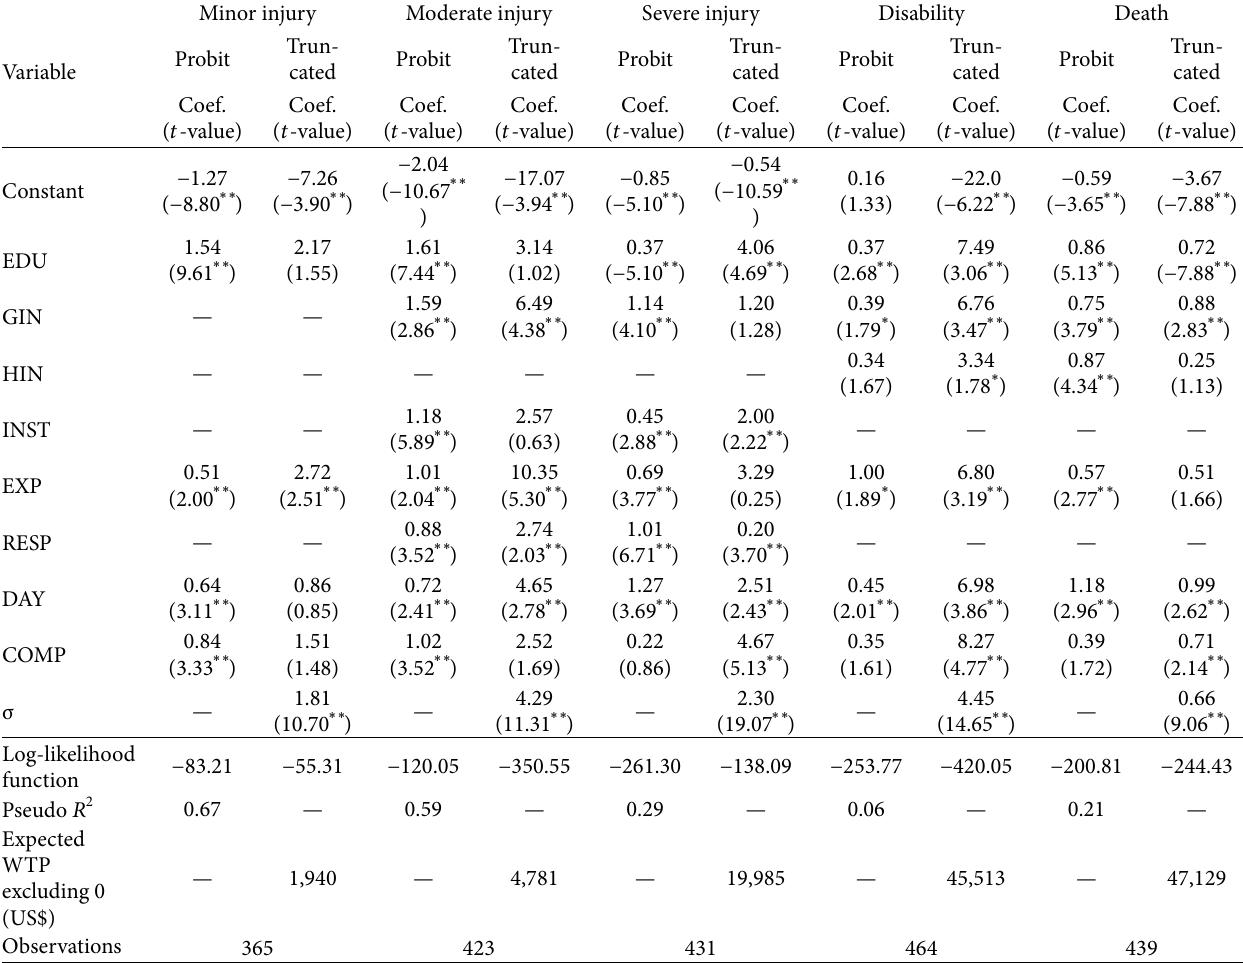
Table 5: Estimation results for WTP (Double-Hurdle model).